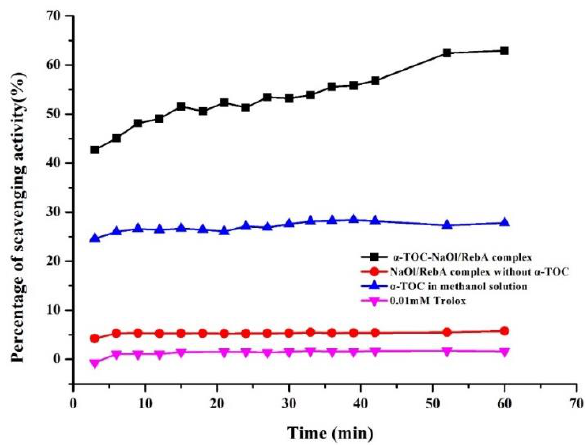
Figure 7. Antioxidant activity of α -TOC-NaOl/RebA complex (concentration of α -TOC was 0.19 mg/mL) assayed for percentage of scavenging activity using ABTS radical scavenging assay, in comparison for same amounts of free α -TOC pre-dissolved in methanol and NaOl/RebA complex without α -TOC.